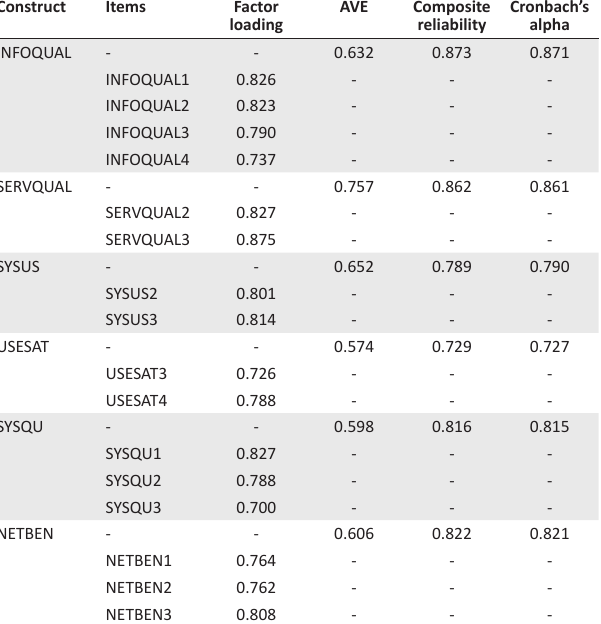
TABLE 3: Reliability and validity test.